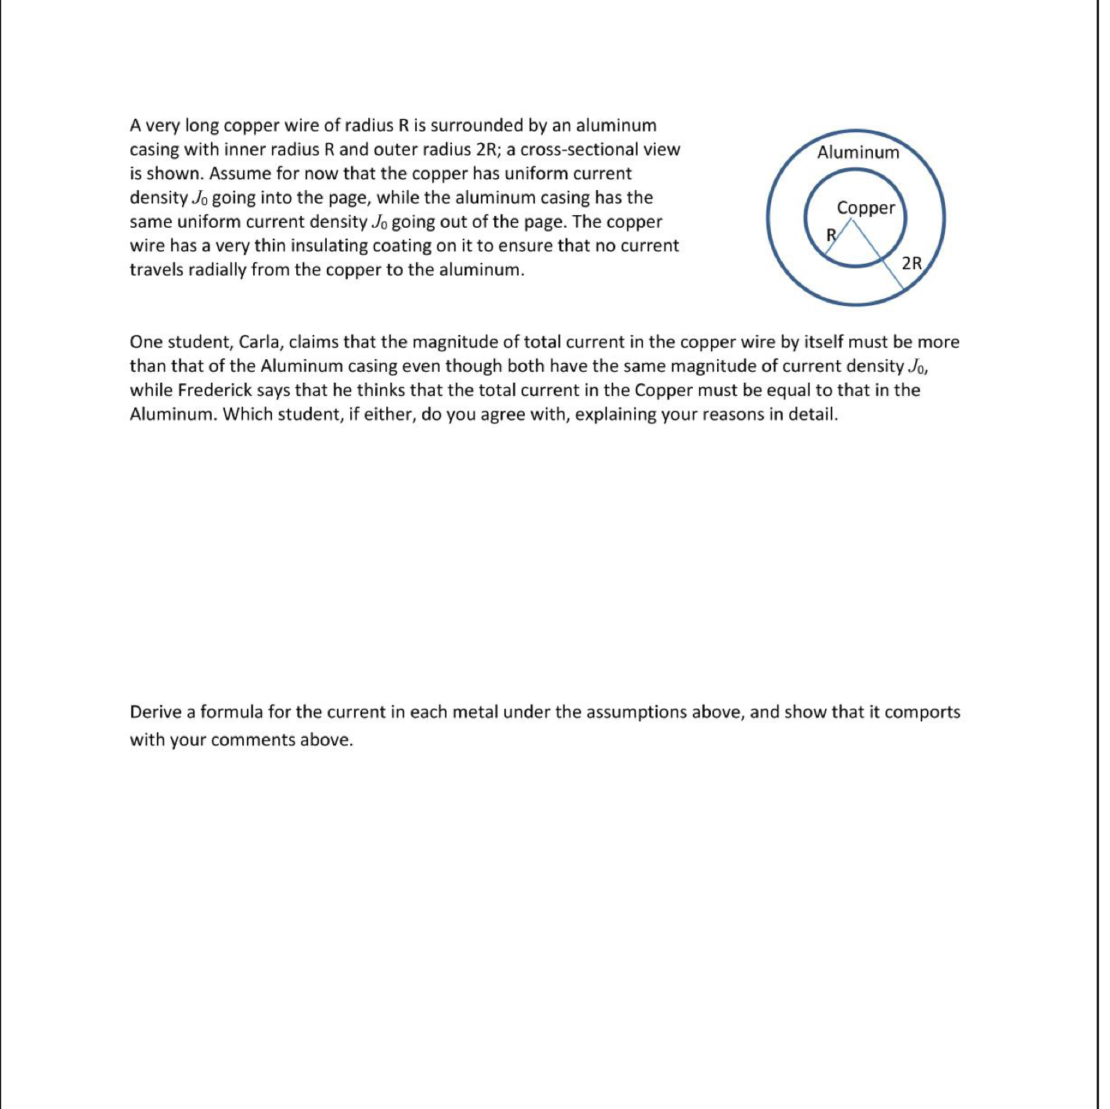
FIG. 12. Aluminum and copper wire problem referenced in Fig. 4, layer 1 of